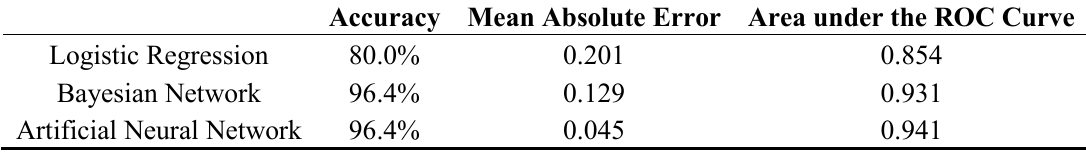
Table 5. Performance of customized mortality predictions models for elderly patients who underwent cardiac surgery.